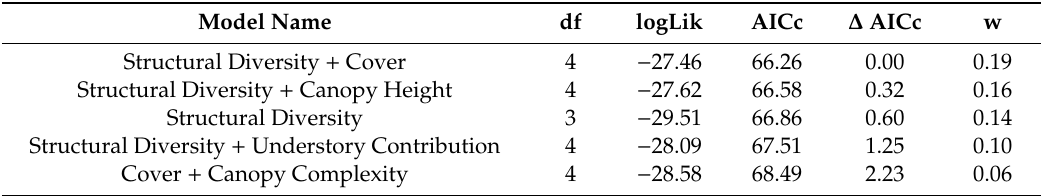
Table 2. Top five models as ranked by AICc for small mammal diversity for plot-level analysis with degrees of freedom (df), log-likelihood values (LogLik), AICc values (AICc), delta AICc values ( ∆ AICc), and weight (w).